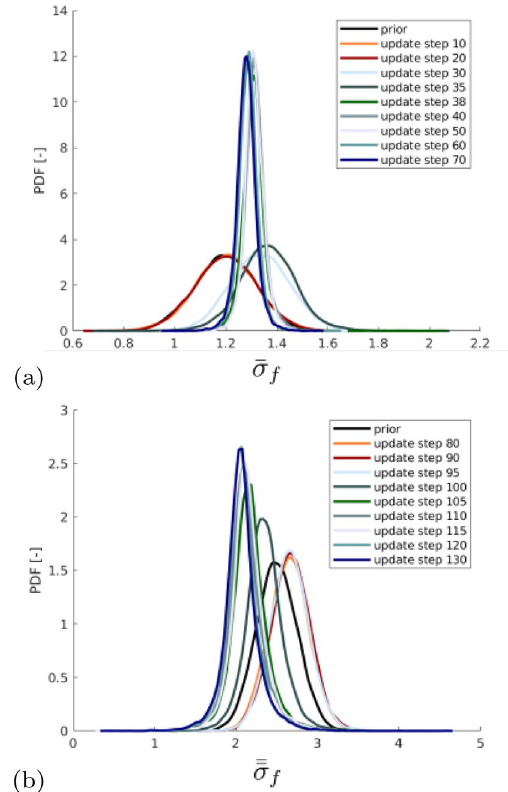
Fig. 22 Posterior probability density function: a limit stress and b ultimate